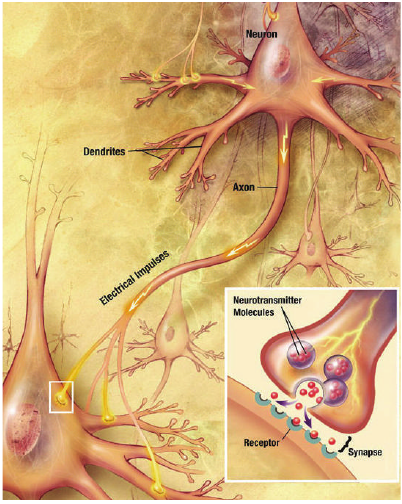
Figure 1: A signal propagating down an axon to the cell body and dendrites of the next cell (Source: